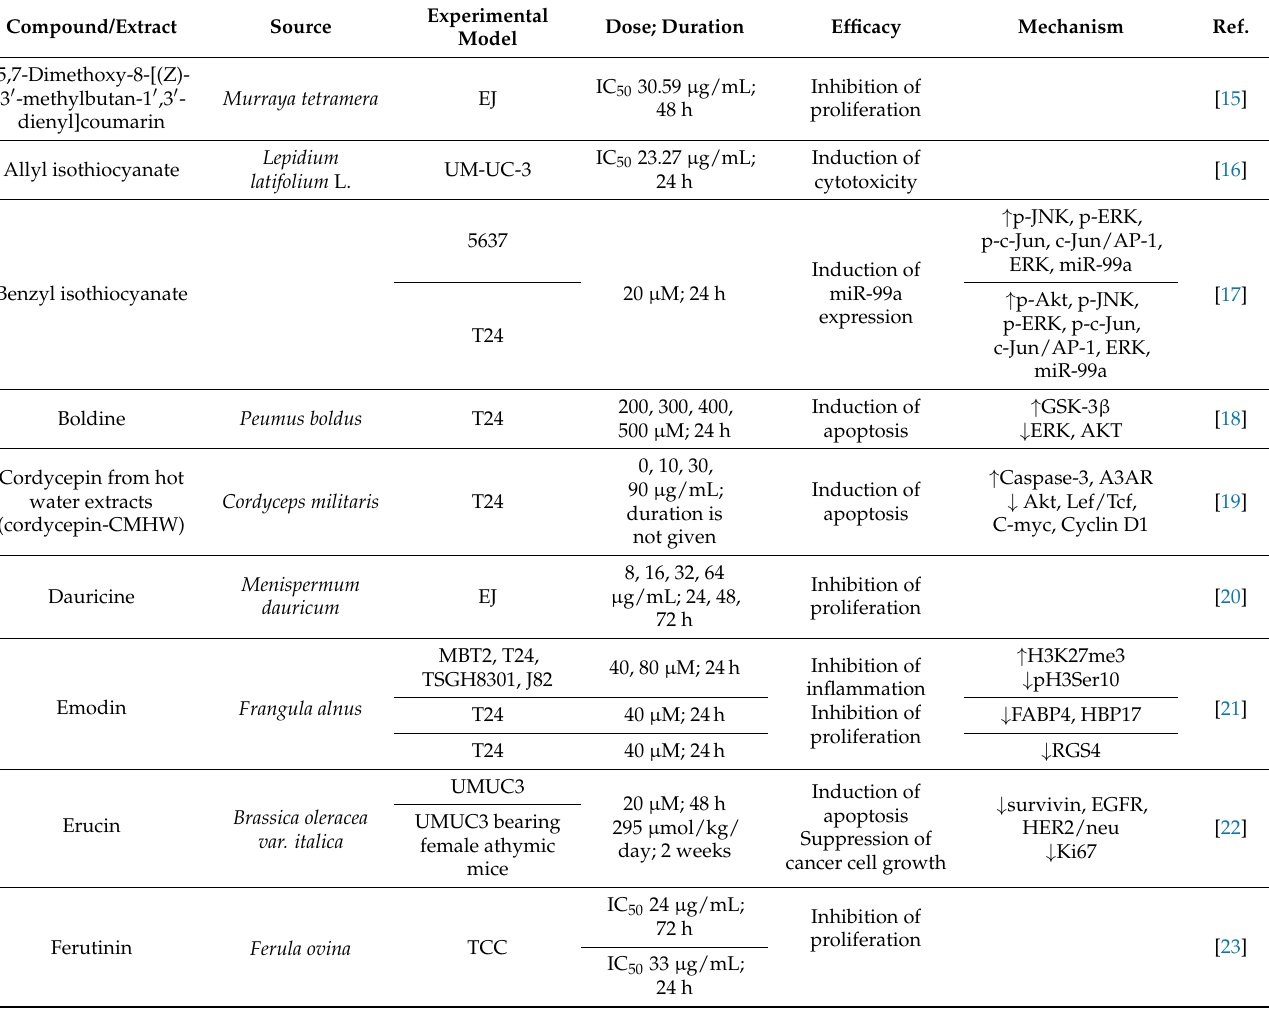
Table 1. Single Natural Compounds inducing